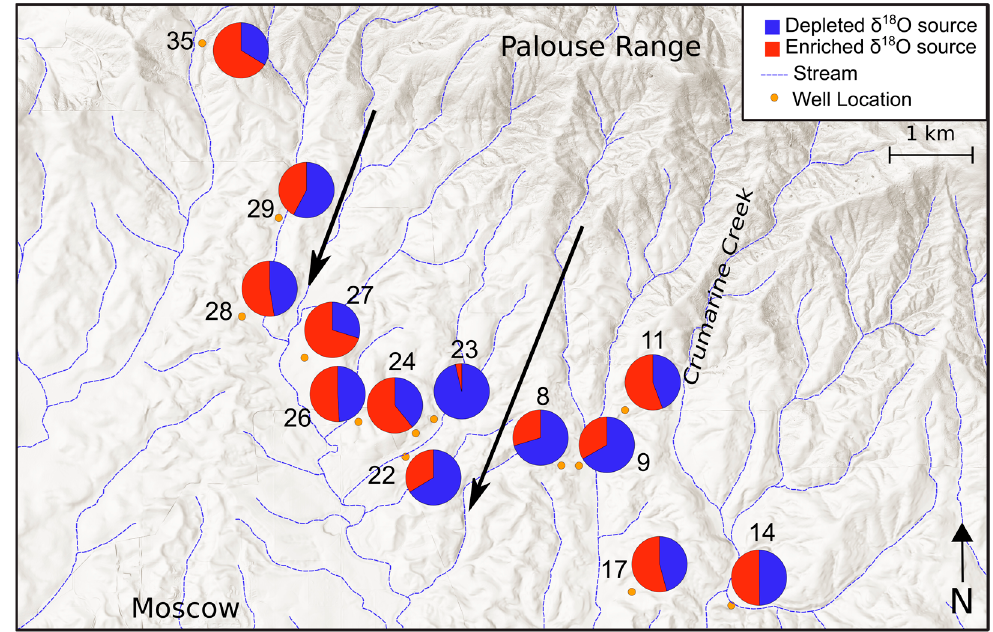
Figure 16. Map view of shifts in groundwater δ 18 O values relative to depleted and enriched values associated with snowmelt and Crumarine Creek, respectively. Arrows indicate locations of perceived faster or more direct recharge pathways containing groundwater with more depleted isotope signals.